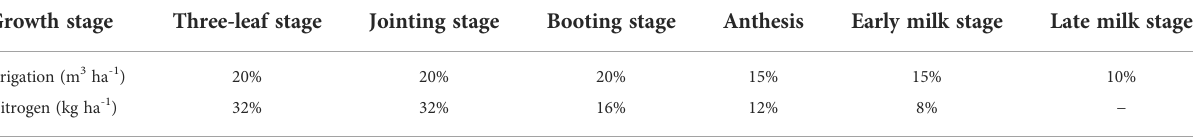
TABLE 1 Irrigation and nitrogen application ratios during different growth periods of